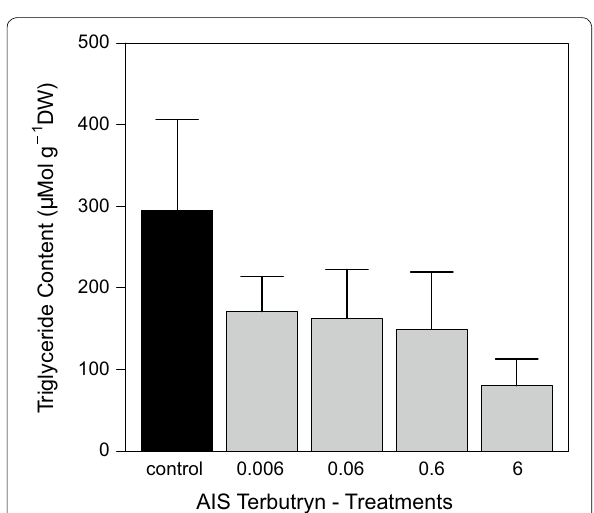
Fig. 5 Grazer triglyceride contents at d 69 in the AIS terbutryn experiment [mean SE, n 6]. All terbutryn treatments in µg L − ± =